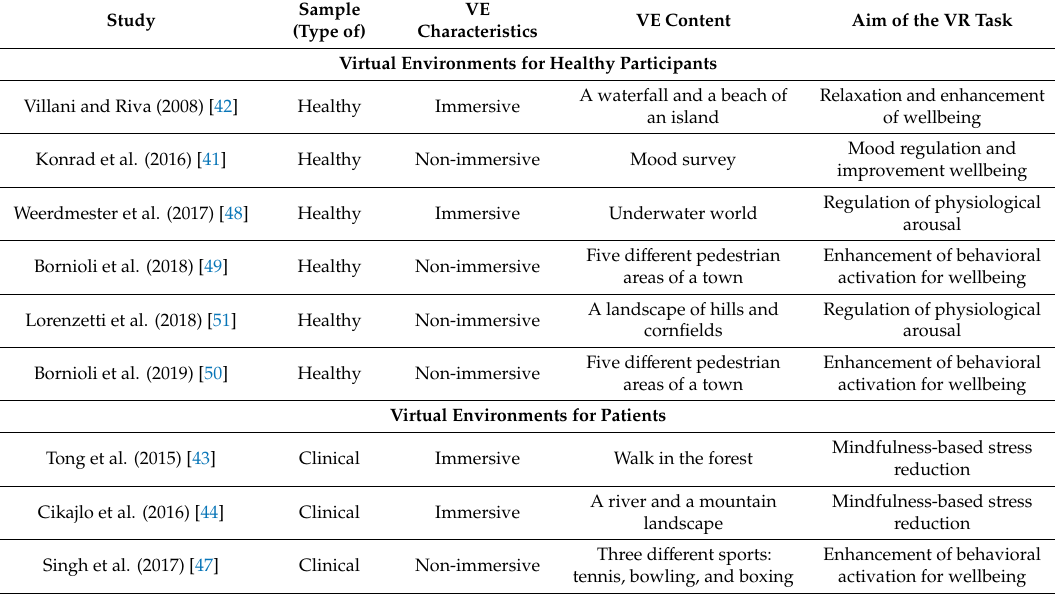
Table 4. Interventions for